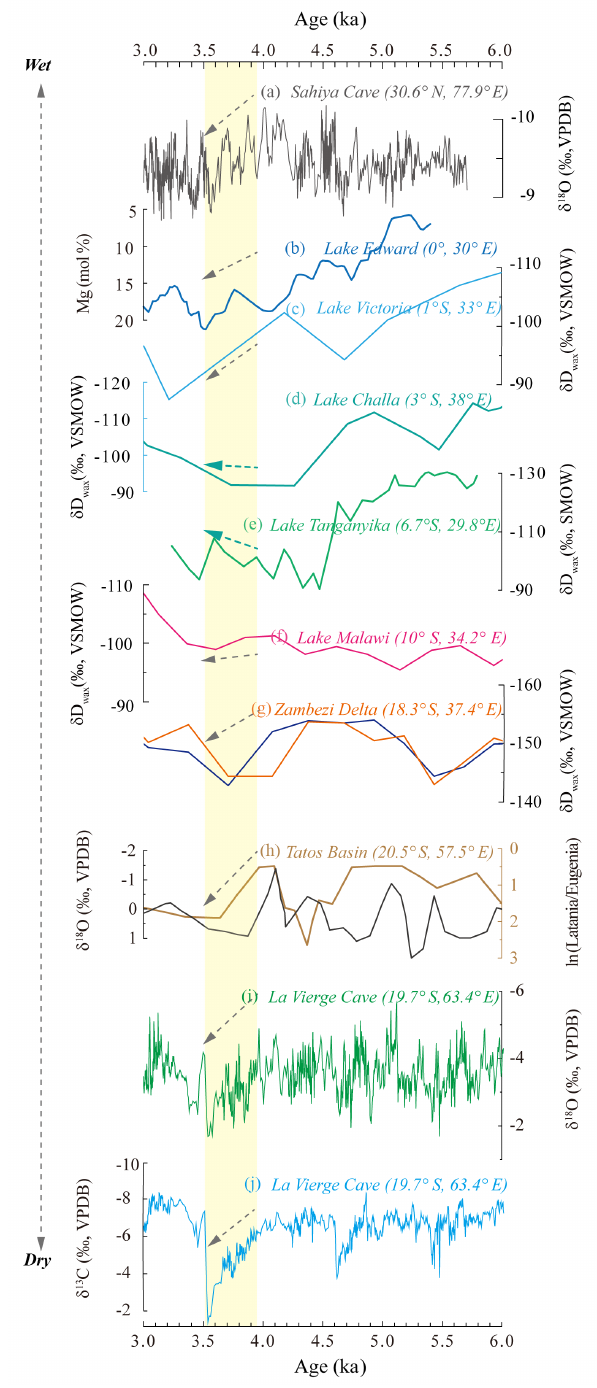
Figure 5. Comparison of LAVI-4 with climate proxy records from India and east Africa. From top to bottom: δ 18 O record from Sahiya Cave (North India; Kathayat et al., 2017), Mg concentration of endogenic calcite from Lake Edward (Russell et al., 2003), δ D leafwax records from Lake Victoria (Berke et al., 2012), Lake Challa (Tierney et al., 2011), Lake Tanganyika (Tierney et al., 2008), Lake Malawi (Konecky et al., 2011), δ D of n-C 29 alkanes (dark blue) and n-C 31 alkanes (orange) from the Zambezi delta (Schefuß et al., 2011), δ 18 O record (black) and ln (Latania/Eugenia) records (brown) from Tatos Basin (Mauritius; De Boer et al., 2014), and the LAVI-4 δ 18 O and δ 13 C record from La Vierge Cave (this study). The shaded vertical bar marks the mega-drought from ∼ 3 . 9 to 3.5ka. Grey and green dashed arrows mark the drying and wet trend inferred from east Africa lake records, respectively. All y axes are inverted to show drier conditions